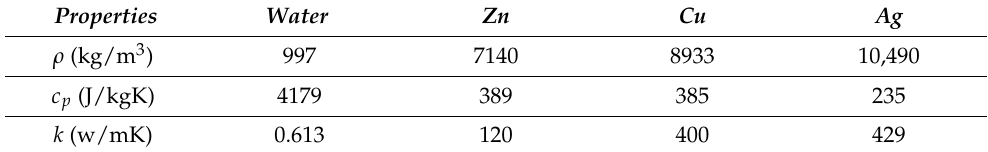
Table 3. Thermophysical properties of selected nanoparticles and pure base fluid (water)